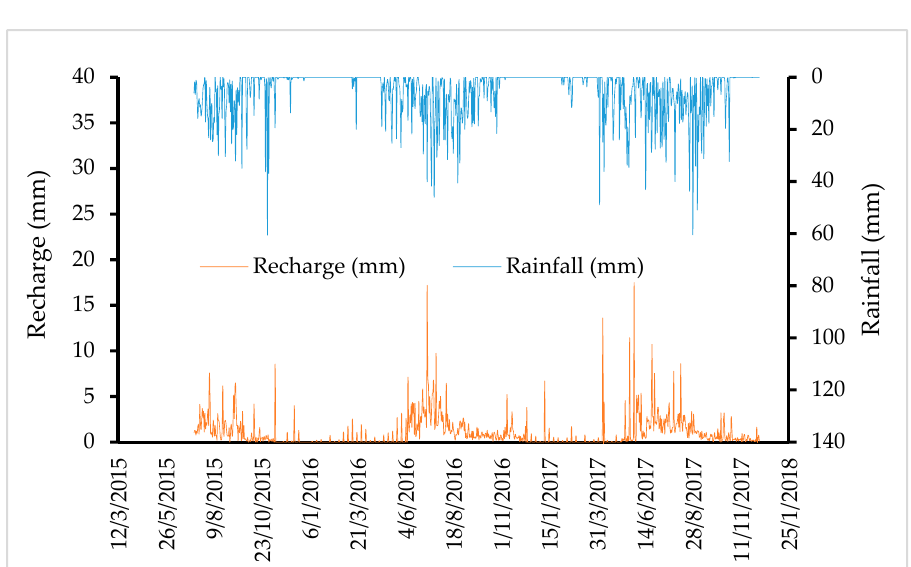
Figure 3. Mean daily shallow groundwater recharge of the monitoring wells and rainfall (2015 to 2017).